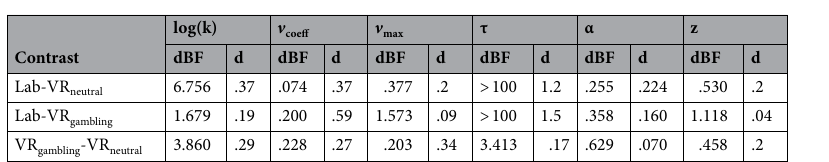
Table 5. Directional Bayes factors (dBF) and effect sizes (Cohen’s d) for all between session comparisons for all parameters of the DDM S . Means and HDIs of the posteriors and difference distributions are summarized in the supplementary materials (Supplementary Table S1). BFs are calculated as BF = i/(1 − i), with i being the probability mass of the difference distributions above zero.